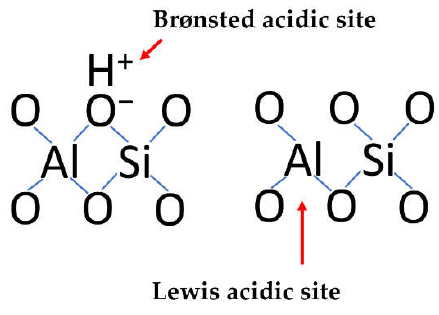
Figure 1. Acidic sites of clays.